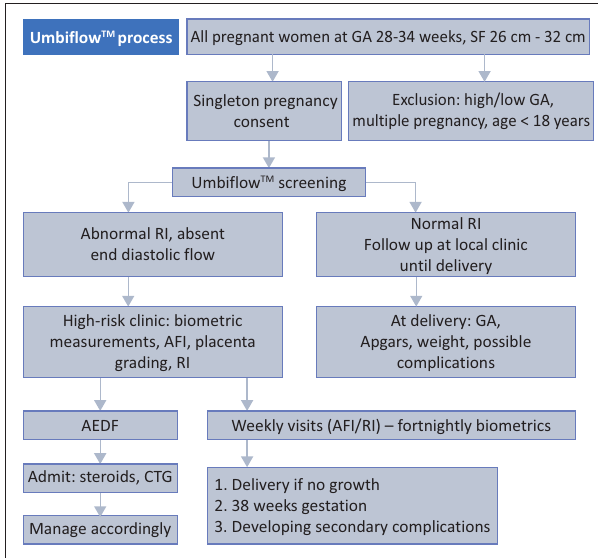
FIGURE 1: Flow diagram of screened population